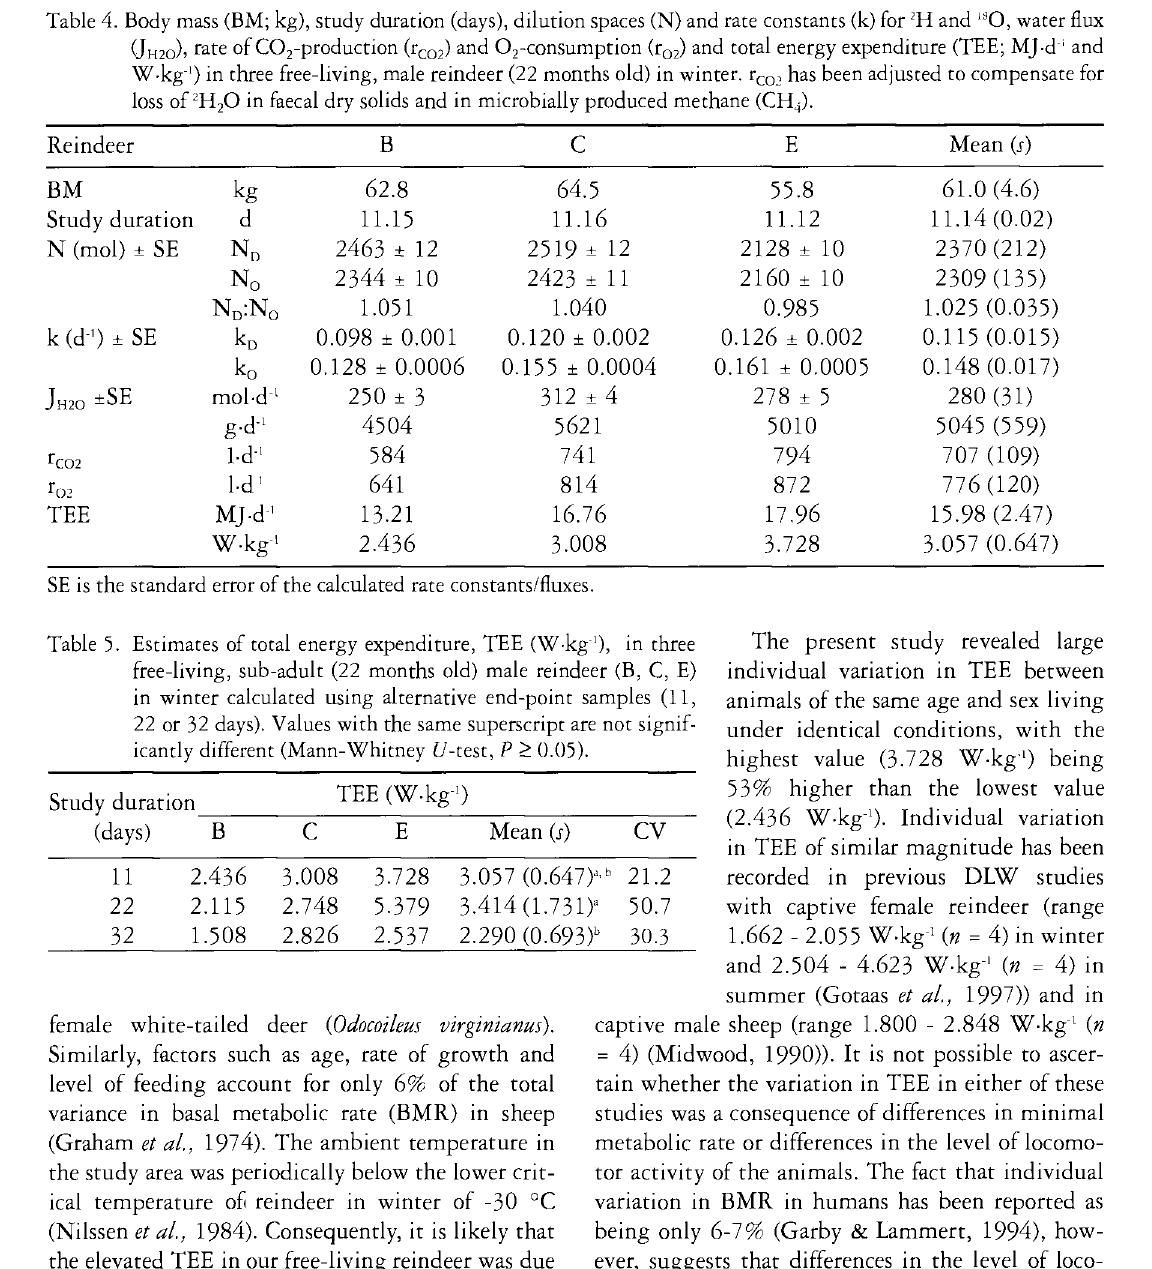
female white-tailed deer (Odocoileus